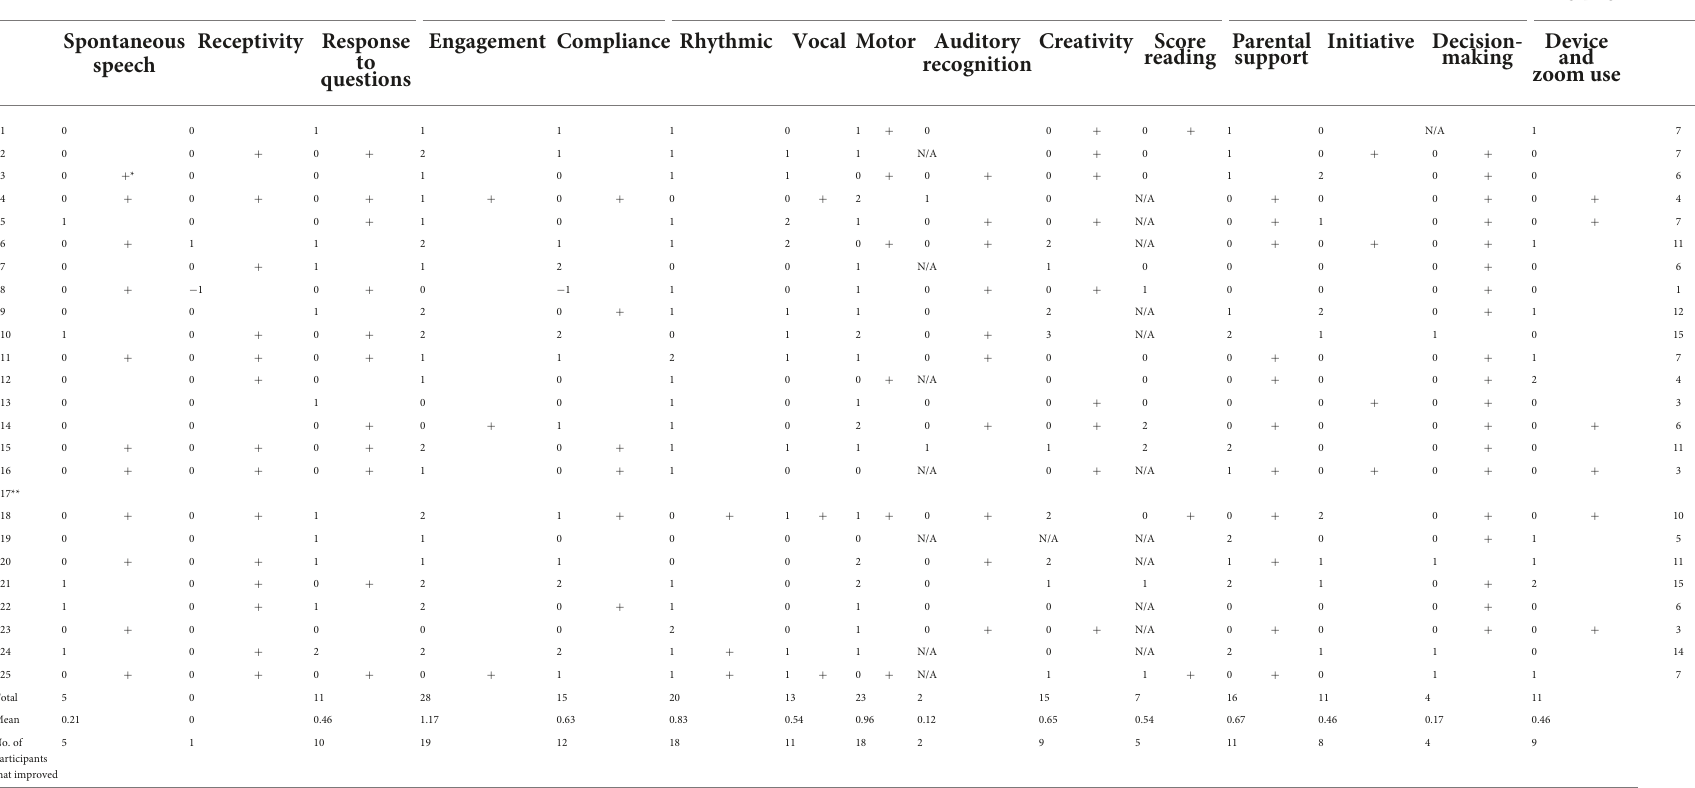
TABLE 3 Participant improvements according to the video